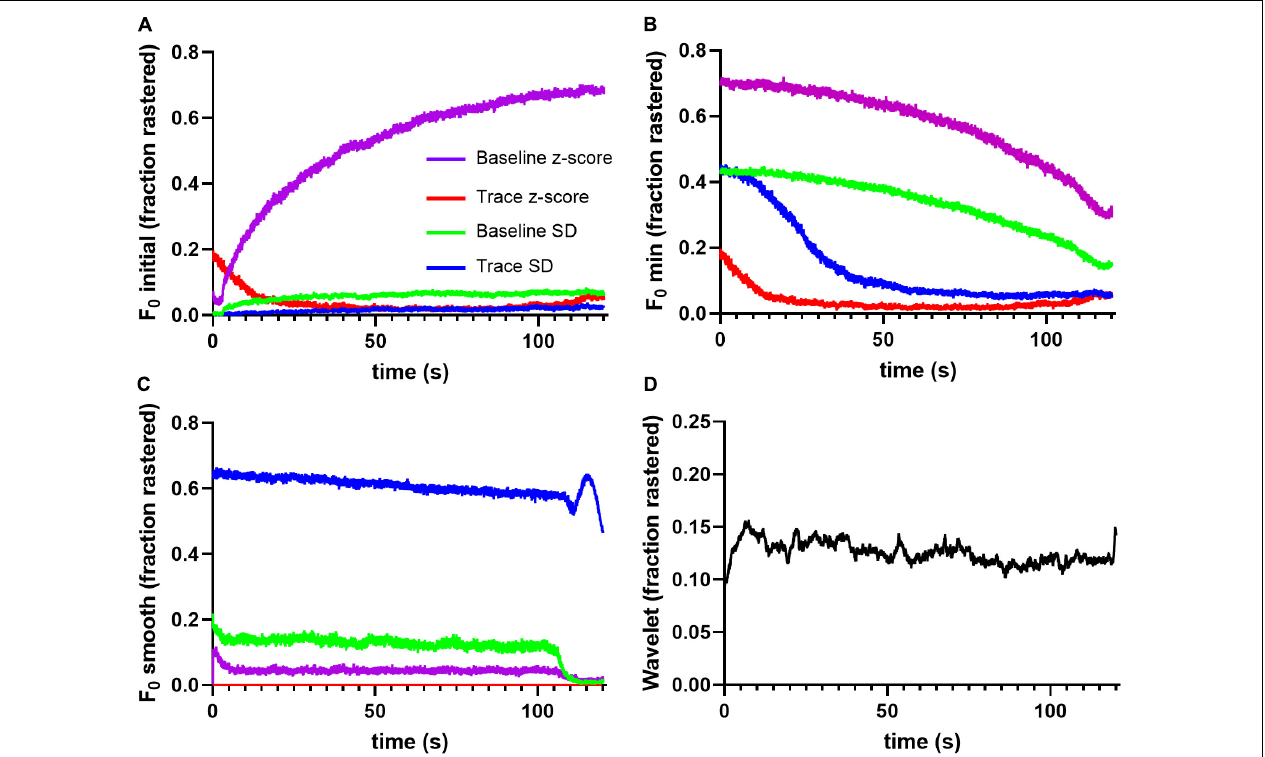
FIGURE 2 | Different event identification methods find different event probabilities. (A) F 0 initial thresholding finds very different, temporally unstable firing probabilities for each thresholding scheme, as does F 0 minimal in panel (B) . (C) F 0 smooth thresholding identifies relatively stable firing probabilities, but the discovered rates vary widely with the thresholding scheme. (D) Wavelet ridgewalking algorithm also produces relatively stable firing